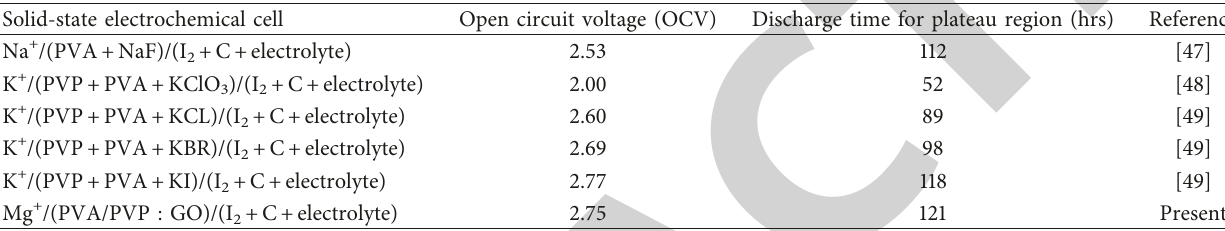
Table 6: Comparison of PVP/PVA : GO nanocomposite polymer films with the other batteries. Solid-state electrochemical cell Open circuit voltage (OCV)